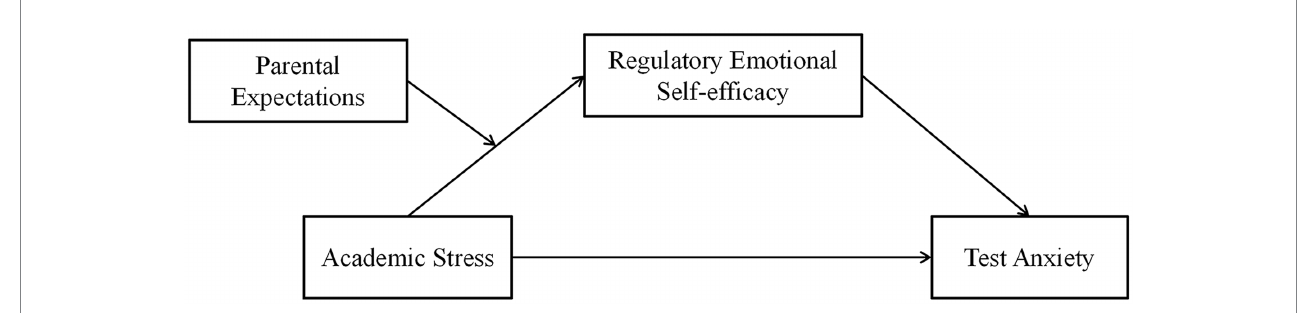
FIGURE 1 Hypothetical model of academic stress, test anxiety, parental expectations and regulatory emotional